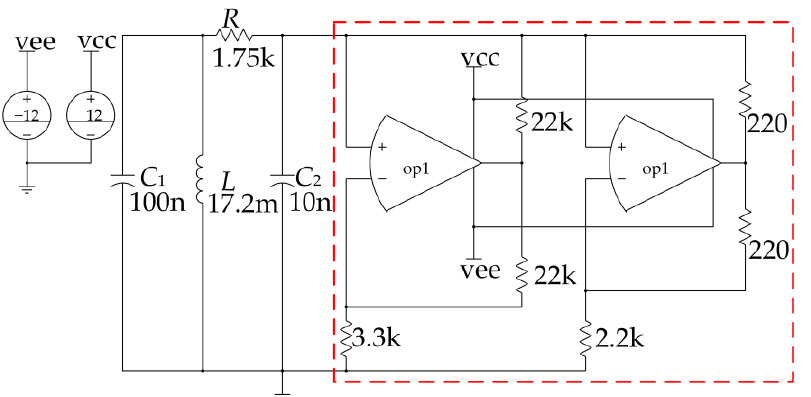
Figure 7. Chua ’ s simulation circuit. Figure 7. Chua’s simulation